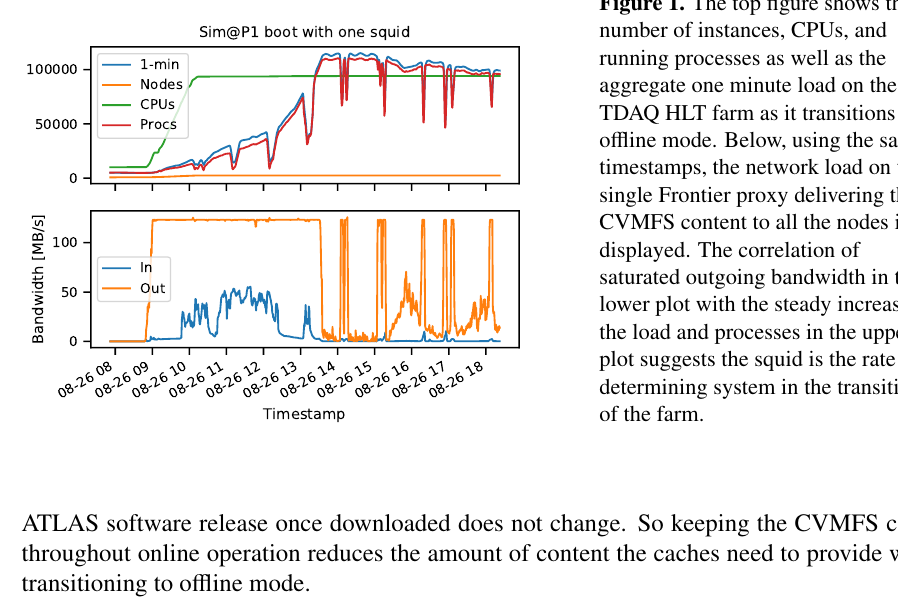
Figure 2. The top figure shows the number of virtual machine instances, CPUs, and running processes as well as the aggregate one minute load on the TDAQ HLT farm as it transitions to o ffl ine mode. Below, using the same timestamps, the network load on the two Frontier squids delivering the CVMFS content to all the nodes is displayed. With the persistent cache the network tra ffi c on the squids is greatly